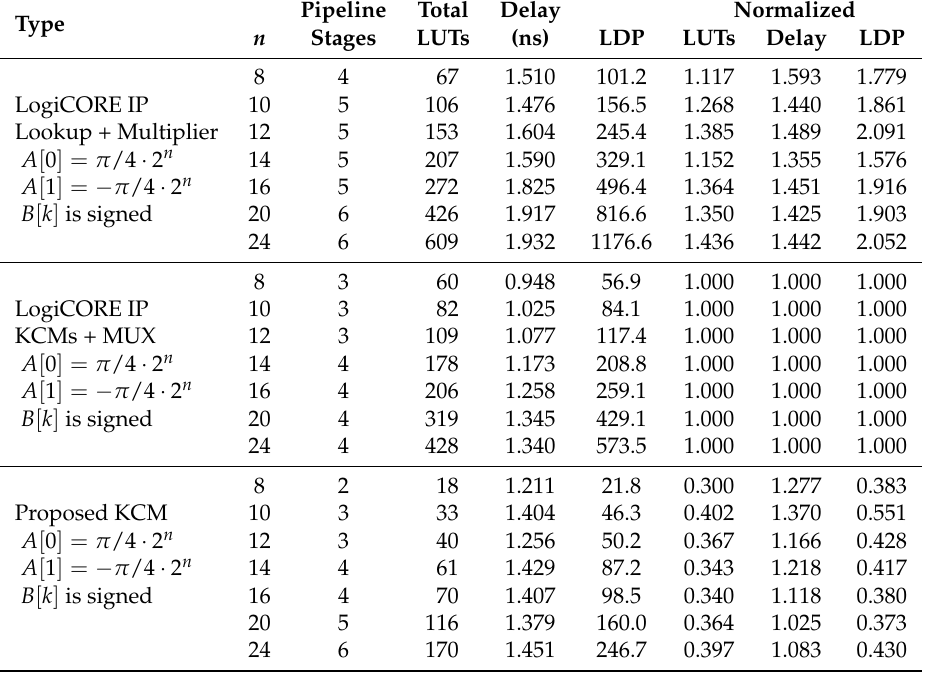
Table 8. Synthesis results for pipelined ( m × n )-bit KCMs with two selectable coefficients, where m = n , A [ k ] = ± π /4 · 2 n and both B [ k ] are signed variables. Proposed units use 64% fewer LUTs and have a 58% lower LDP on average compared to LogiCORE IP KCM-based